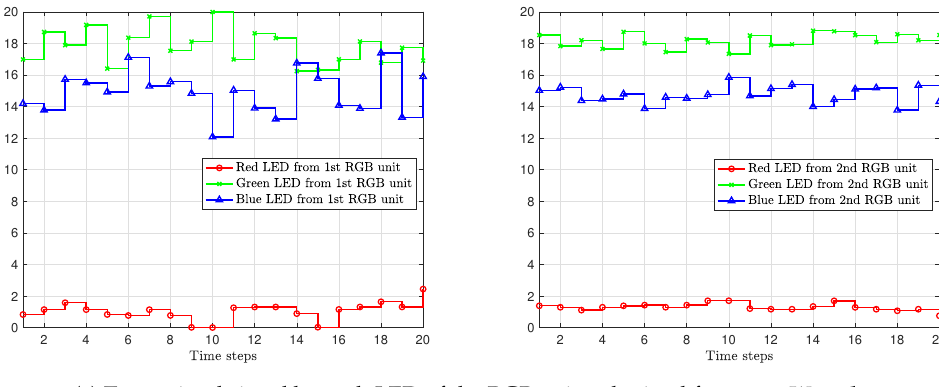
Figure 3. Illustration of the signals generated in a system with N = 2 RGB units, each one with one red, one green, and one blue LED, and K = 2 users, both supporting 4-PAM: ( a ) users’ streams (3 symbols stream per user), ( b ) linear combination of the users’ streams to be sent by each LED, and ( c ) final optical power emitted by each LED. The R, G, and B primaries correspond to set 2 specified in Table